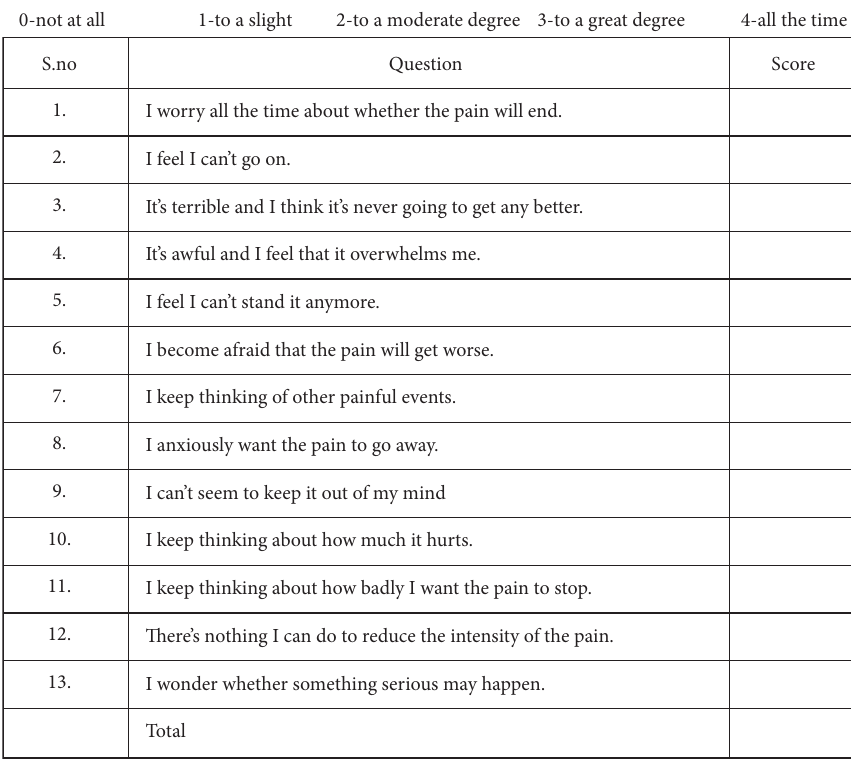
Figure 2: The form used to collect data using the Pain Catastrophizing